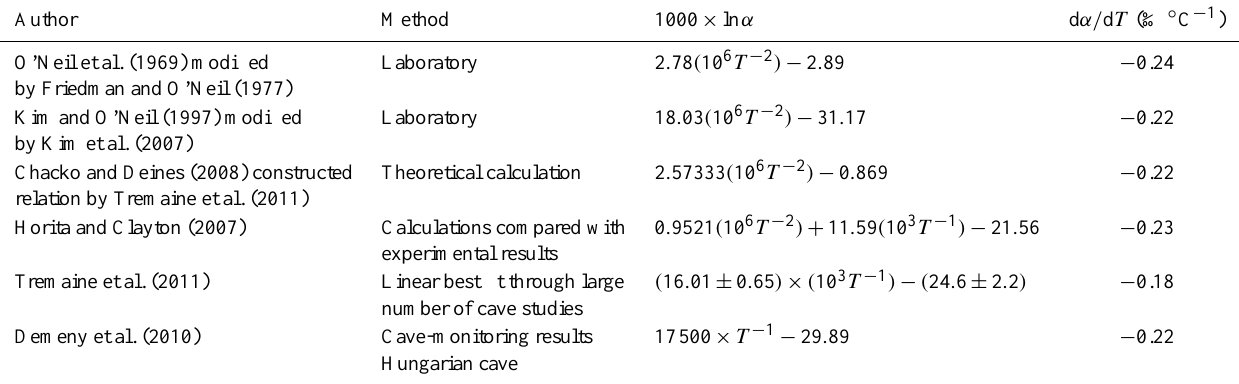
Table 1. A selection of the most commonly used water–calcite oxygen fractionation factors. Laboratory and theoretical approaches differ from the relationships found in cave